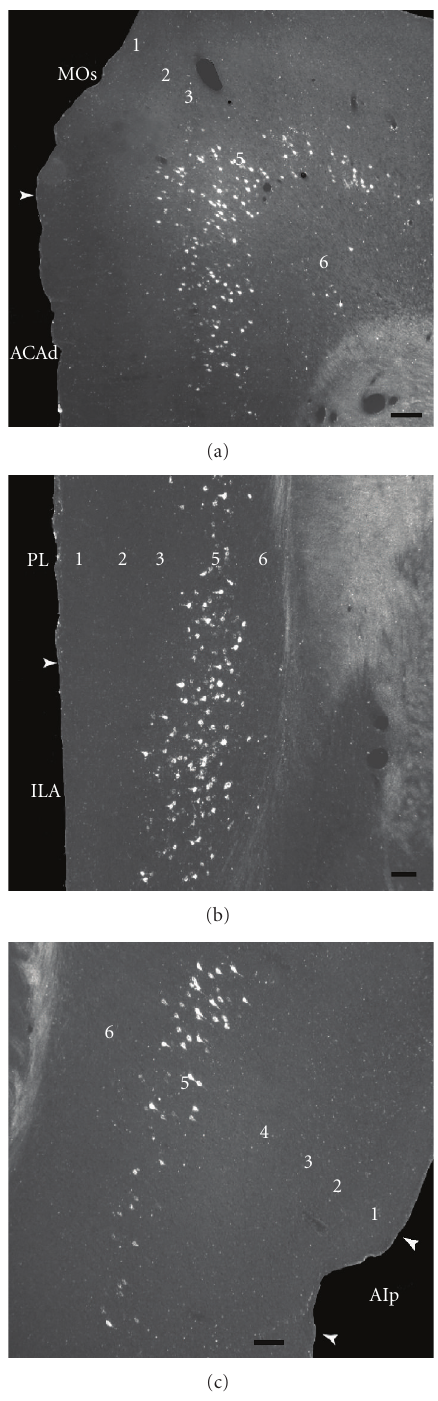
Figure 3: Dark field photomicrographs showing (a) the distribu- tion of retrogradely labeled cells within the ipsilateral secondary motor area and the dorsal part of the anterior cingulated area; (b) the prelimbic and infralimbic areas; (c) and the visceral area. Scale bars = 200 µ